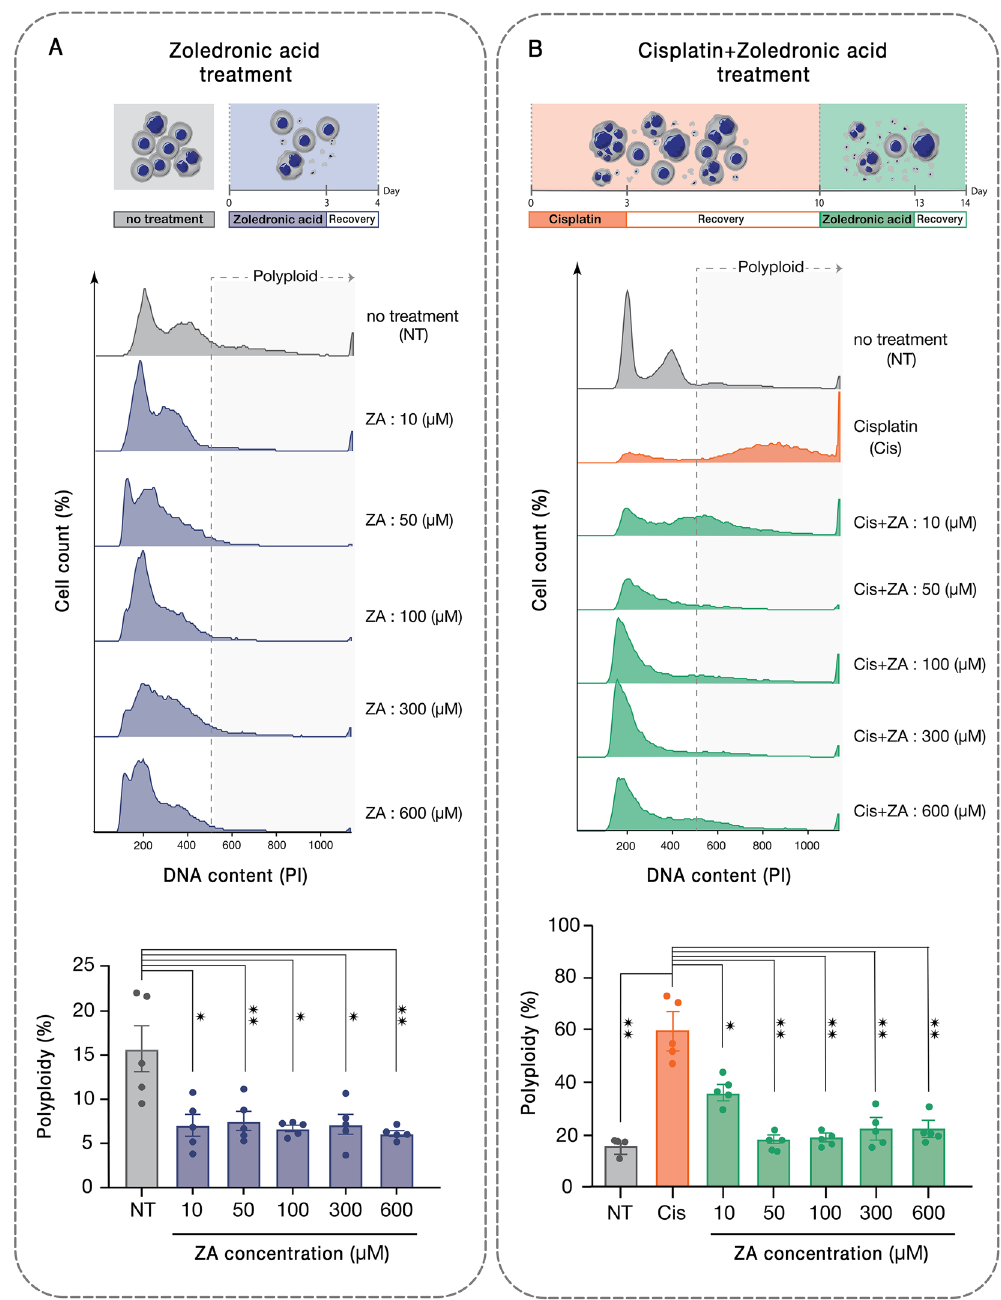
Figure 2. Zoledronic acid declines the population of PGCCs pre- and post-cisplatin administration. (A) DNA content analysis of 5637 bladder cancer cells treated with different doses of ZA indicates the reduction of PGCCs post-treatment. (B) Cisplatin administration enriches PGCCs and ZA at different doses from 10–600 μM declines the PGCC population with the most profound effect being observed at 50 μM. * p- value < 0.05; ** p- value < 0.01; error bars: mean ±